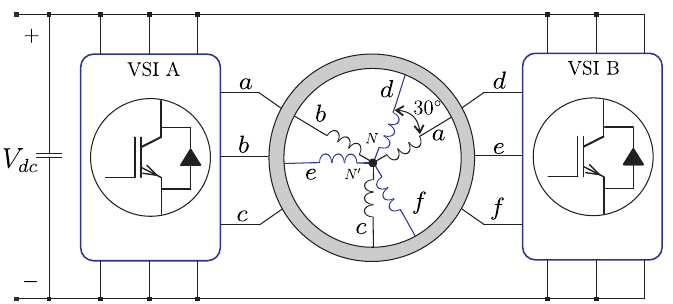
Figure 1. Six-phase IM topology supplied trough a two-level six-phase